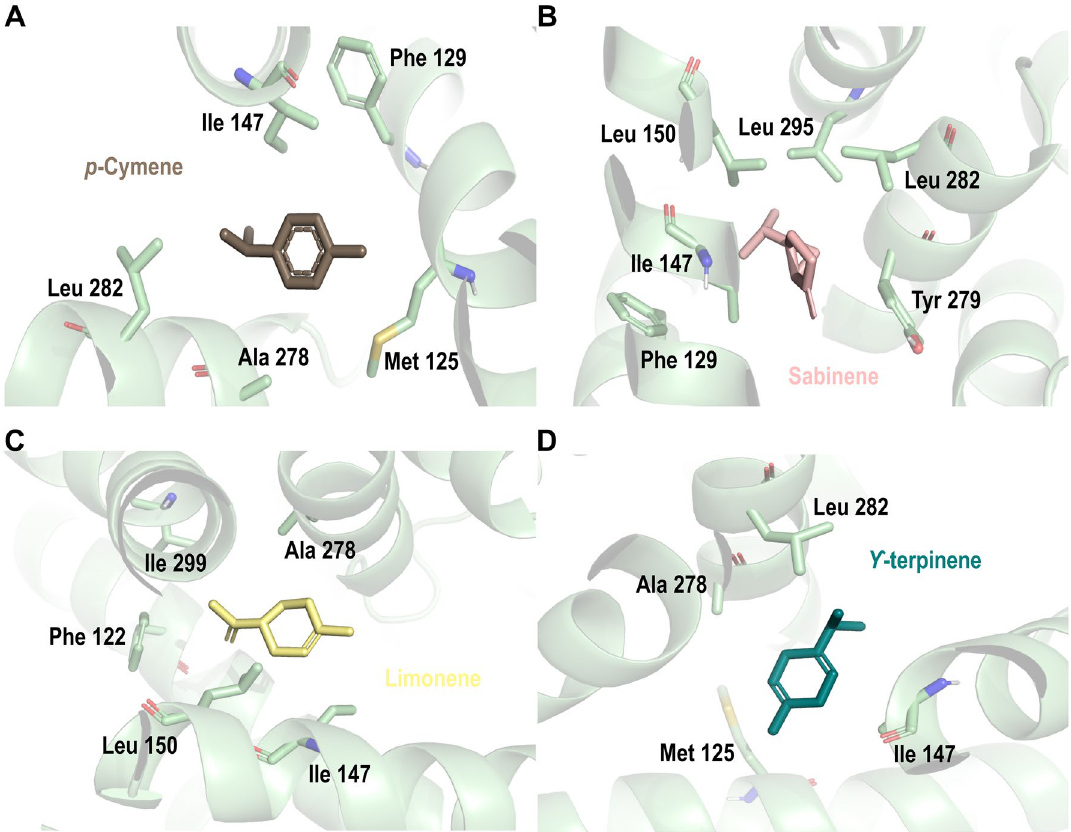
Figure 7. Docking poses of best ranked secondary metabolites on subunit A of mitochondrial complex III in Aedes aegypti . ( A ) p -cymene; ( B ) sabinene; ( C ) limonene; ( D ) γ-terpinene. Mitochondrial complex III’ residues are colored according to the atom type of the interacting amino-acid residues (protein’s carbon, pale green; oxygen, red; nitrogen,